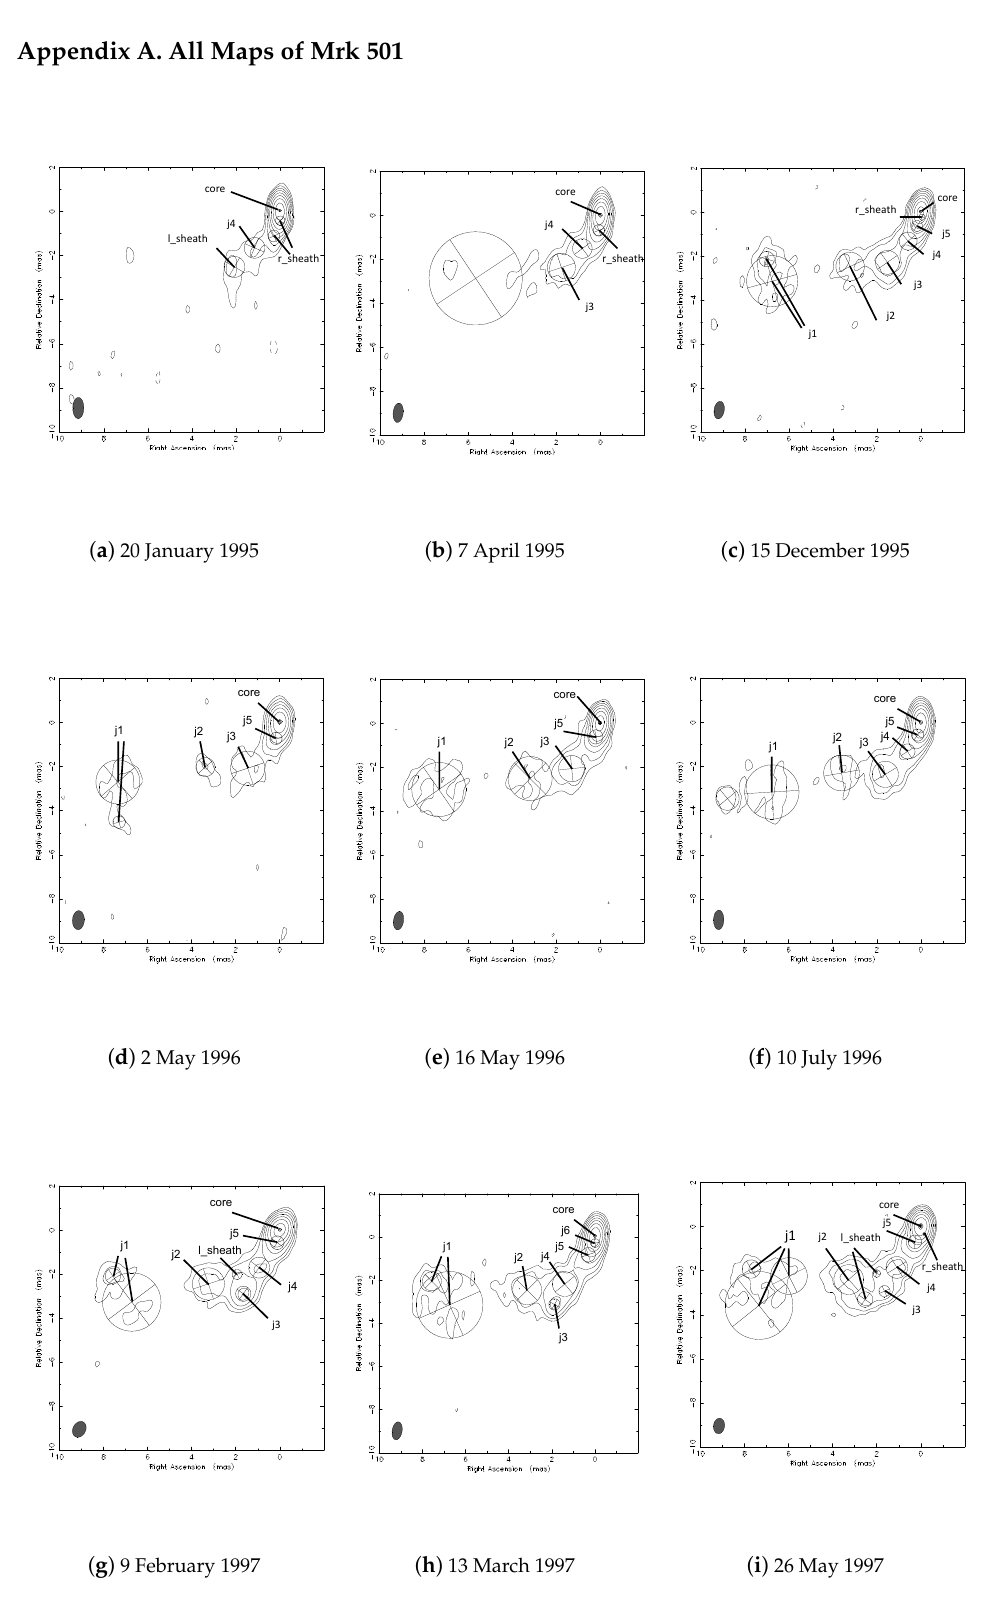
Figure A1. The jet mapped with the VLBA at 15 GHz at nine different epochs between 20 January 1995 and 26 May 1997. Superimposed are the labels of the model-fit Gaussian components. Note that not every jet component is identifiable in each